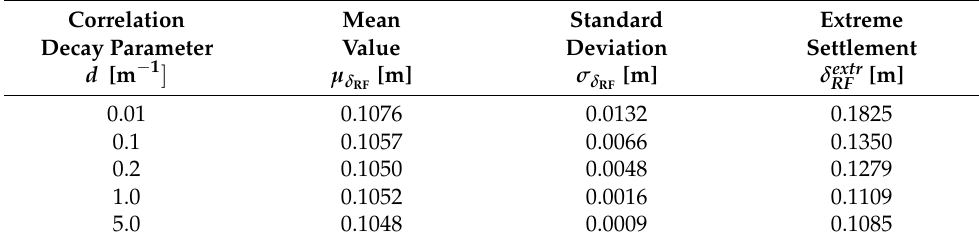
Table 1. Soil block settlement parameters, 200-item simulation procedure, random field approach.